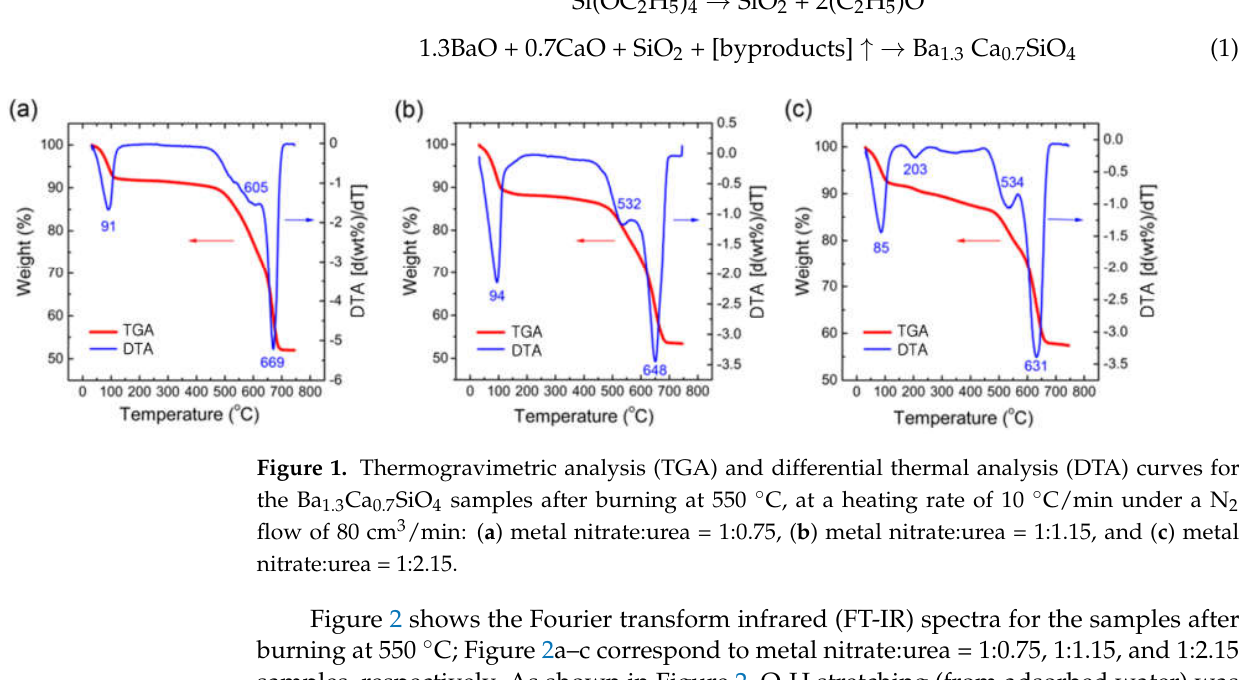
Figure 1. Thermogravimetric analysis (TGA) and differential thermal analysis (DTA) curves for the Ba 1.3 Ca 0.7 SiO 4 samples after burning at 550 °C, at a heating rate of 10 °C/min under a N 2 flow of 80 cm 3 /min: ( a ) metal nitrate:urea = 1:0.75, ( b ) metal nitrate:urea = 1:1.15, and ( c ) metal nitrate:urea = 1:2.15.